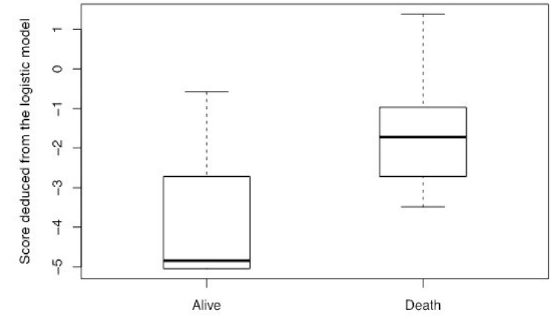
Fig. 1 (abstract 001123). See text for description